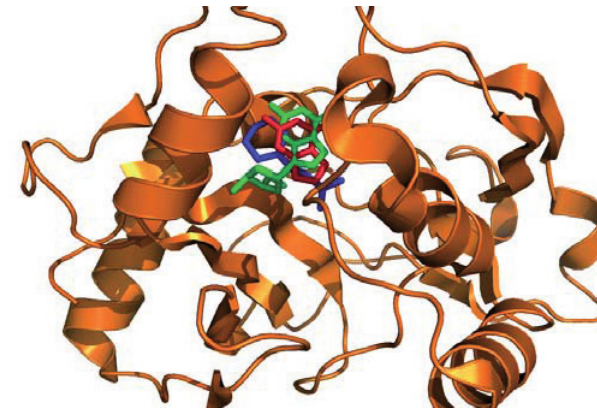
Figure 8. Target ligands superimposed on the query protein structure. The query structure 2pd0 (in orange) is used as reference in which the target binding site ligands guanine (GUN; from PDB entry 1v2h in red) and 5-(6-Amino-2-Fluoro-Purin-9-Yl)-2- Hydroxymethyl- Tetrahydro-Furan-3- Ol [2-Fluoro-2´-Deoxyadenosine] (2FD; from PDB entry 1pke, in green) are superimposed based on their binding site similarities to the query cleft defined by the bound ligand 2-(N-Morpholino)-Ethanesulfonic acid (MES, in blue). A good quality superimposition of the aromatic rings of the different ligands is obtained as a consequence of the superimposition of the binding sites performed by IsoCleft.